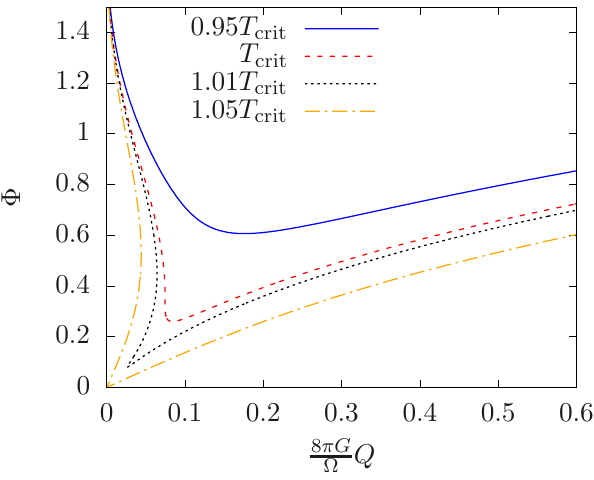
Figure 6 . Plots of (cid:8) vs. Q for various (cid:12)xed temperatures, 0 : 95 T crit , T crit , 1 : 01 T crit , and T crit , for n = 0 : 6, (cid:23) = 0 : 3, ‘ 2 = L 2 = 2, and D = 4. For these parameters, the critical temperature is T crit 0 : ’